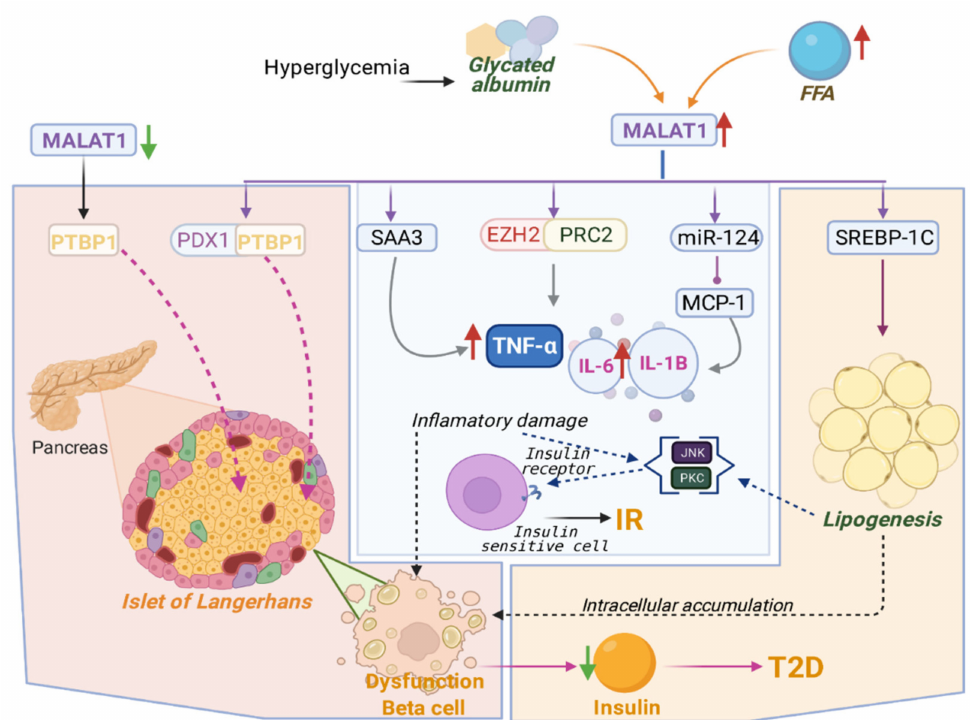
Figure 1. Role of metastasis-associated lung adenocarcinoma transcript 1 (MALAT1) in the molec- ular mechanisms of insulin resistance. The downregulation of MALAT1 affects the modulation of polypyrimidine tract-binding protein 1 (PTBP1), demonstrating that it contributes to the dysfunction of pancreatic β -cells and the development of type 2 diabetes (T2D). In states of hyperglycemia and high levels of free fatty acids (FFAs), MALAT1 is overexpressed through the activation of the PDX1/MALAT1/PTBP1 axis and indirectly promotes the overexpression of tumor necrosis factor- alpha (TNF- α ), interleukins (IL)-6, and IL-1 β when bound to polycomb repressive complex 2 (PRC2), inhibiting the expression of anti-inflammatory genes. Glycated albumin induces monocyte chemoat- tractant protein-1 (MCP-1) expression, which depends on the MALAT1/miR-124 axis. MALAT1 directly interacts with SREBP-1c, inhibiting its ubiquitination and increasing its activity, which leads to the expression of its target lipogenic genes, thus inducing intracellular lipid accumulation and IR. Increased transcription of proinflammatory and lipogenic genes leads to the activation of threonine/serine kinases c-Jun-N-terminal kinases (JNK) and phosphokinase C (PKC), which are associated with the negative regulation of insulin